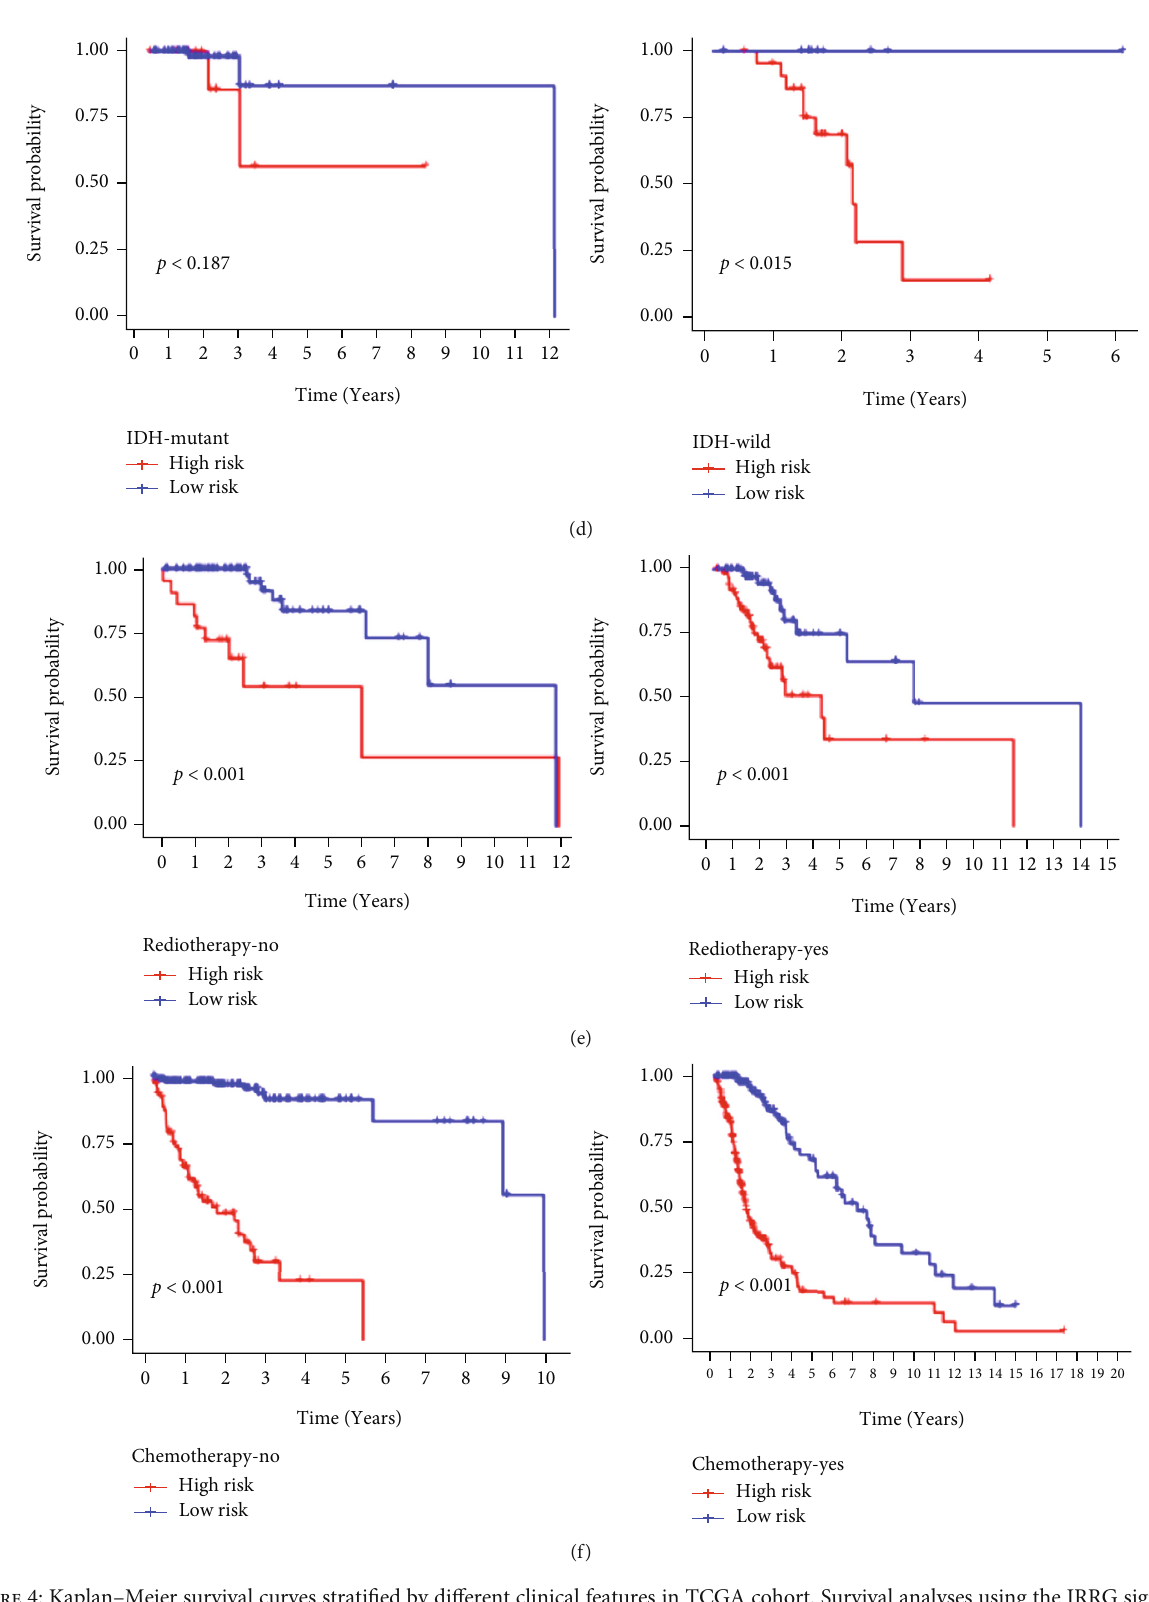
Figure 4: Kaplan – Meier survival curves strati fi ed by di ff erent clinical features in TCGA cohort. Survival analyses using the IRRG signature in patients with di ff erent (a) ages, (b) gender, (c) grade, (d) IDH, (e) radiotherapy, and (f)